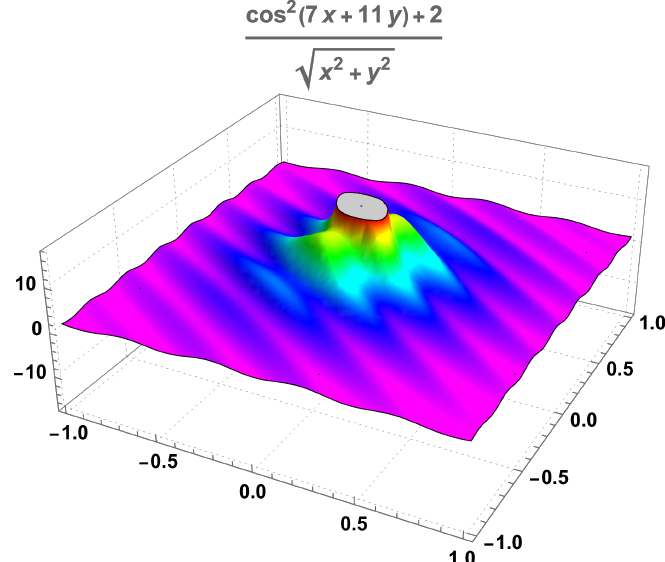
Figure 3. A nearly unbounded function having several local maxima.